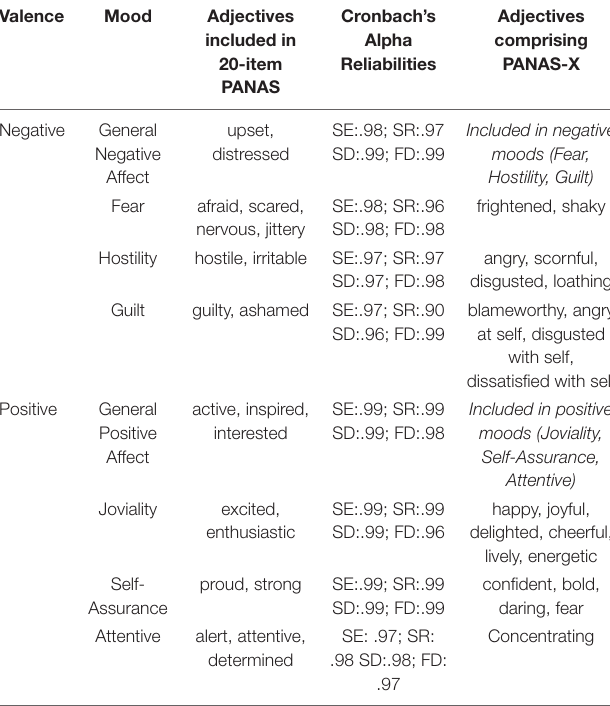
TABLE 1 | Adjectives contributing to measurement of specific Negative and Positive moods and their